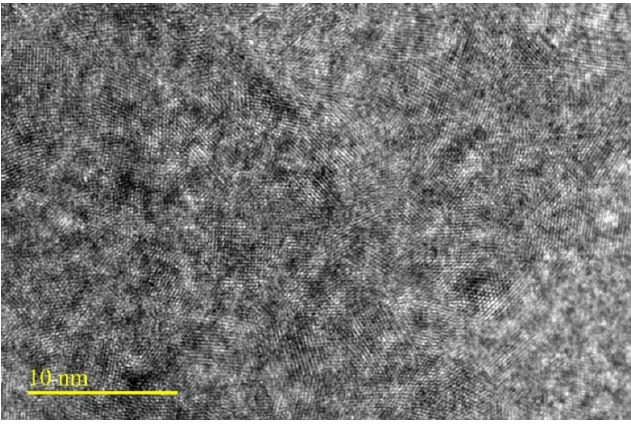
Figure 7. TEM image of raw dolomite particles. Table 1. The physical properties of dolomite and calcite.